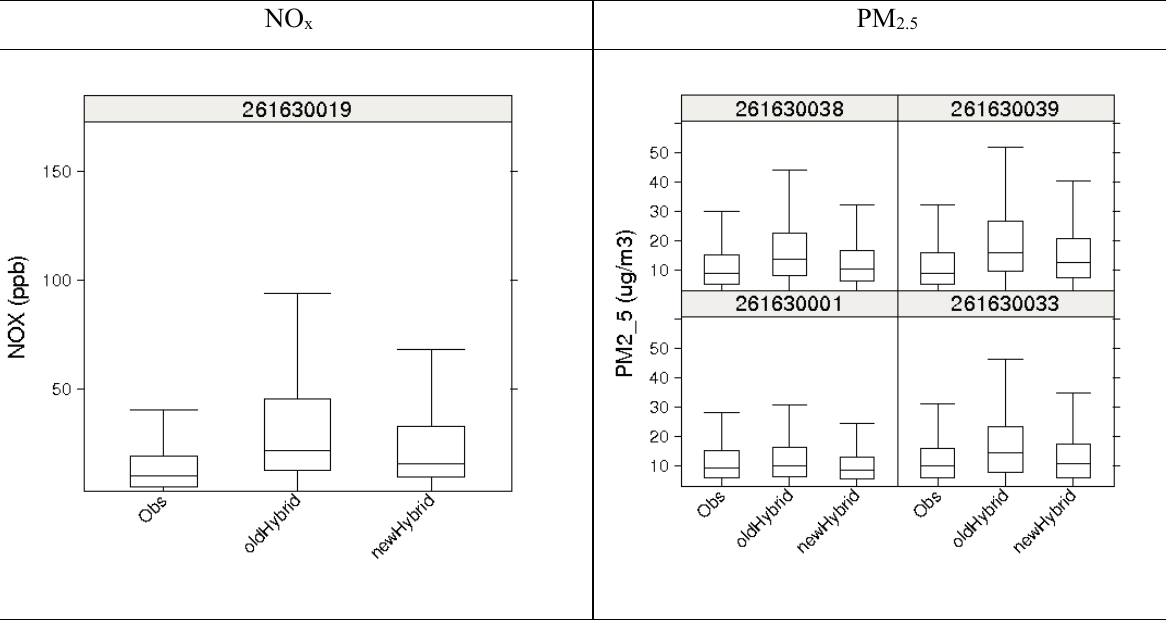
Figure 12. Comparison of distributions of hourly averaged observations paired spatially and temporally against hybrid estimates from the two STOK methods, one using all observed measurements as hard data ( old hybrid ) and the other using observations that were either soft or hard depending on the classification as background or not ( new hybrid ). NO PM x